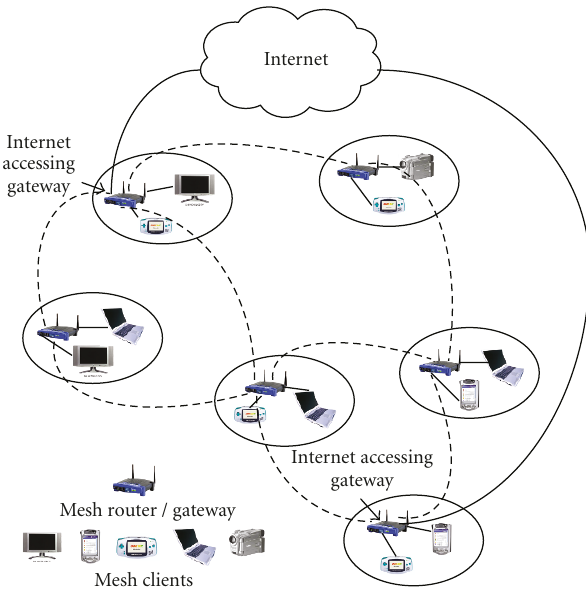
Figure 1: A typical